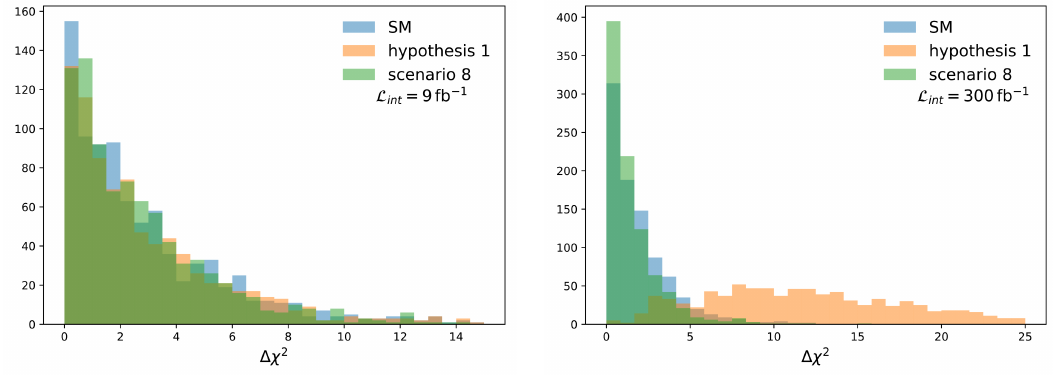
Figure 21 . ∆ χ 2 distributions for three physics scenarios for (left) 9 fb − 1 and (right) 300 fb − 1 of